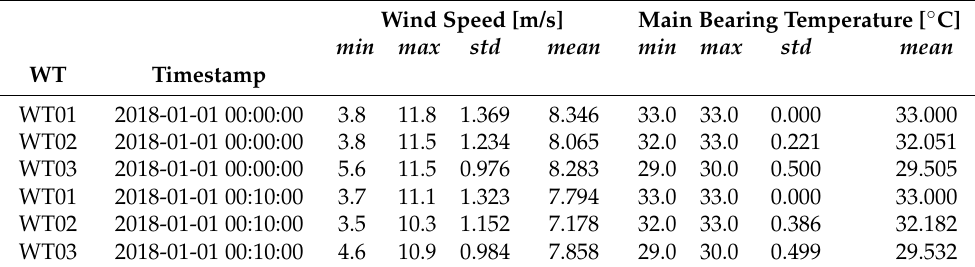
Table 1. Sample of SCADA data for a limited selection of turbines and signals. Each signal is stored completed with its minimum ( min ), maximum ( max ), mean ( mean ), and standard deviation ( std ) values. The frequency of the data is 10 min.